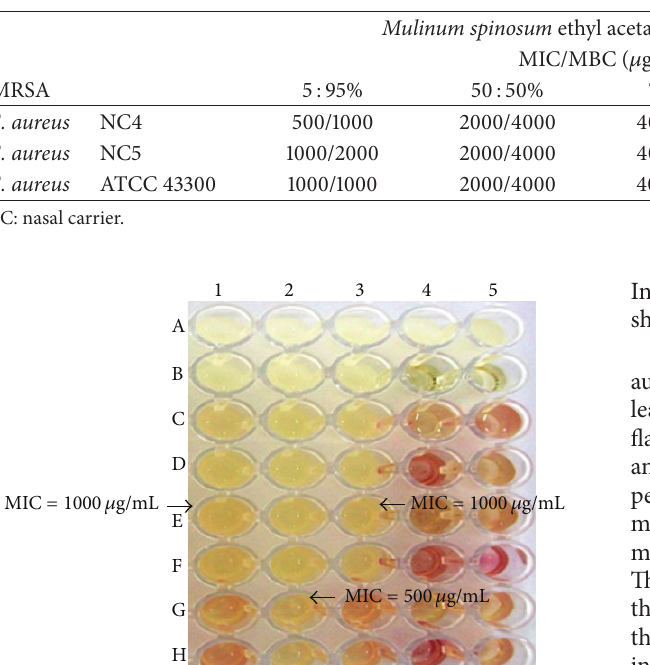
Table 2: Minimal inhibitory concentration and minimal bactericidal concentration of M. spinosum extracts against methicillin-resistant S. aureus .